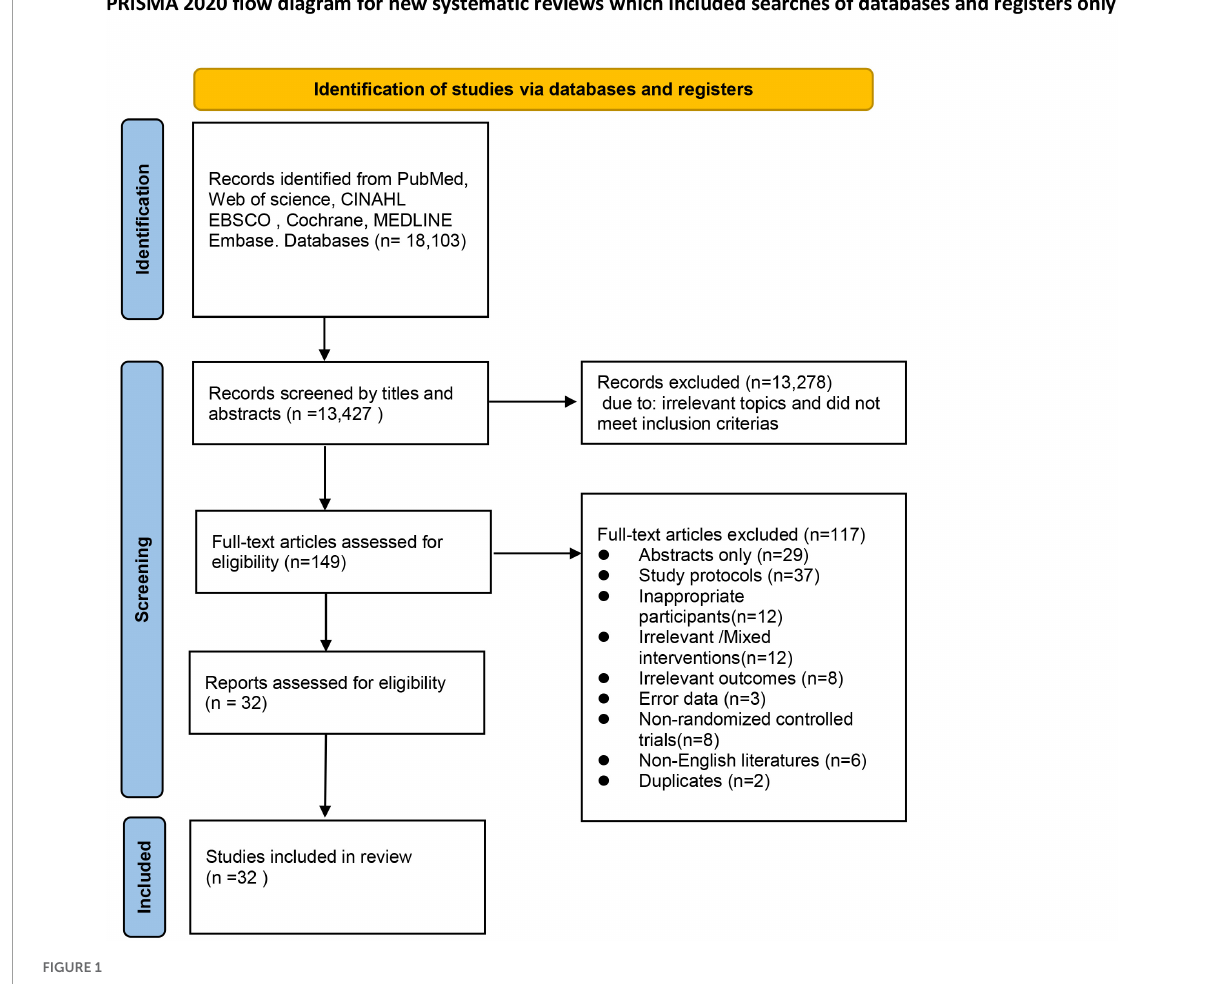
FIGURE1 PRISMA flow diagram of study